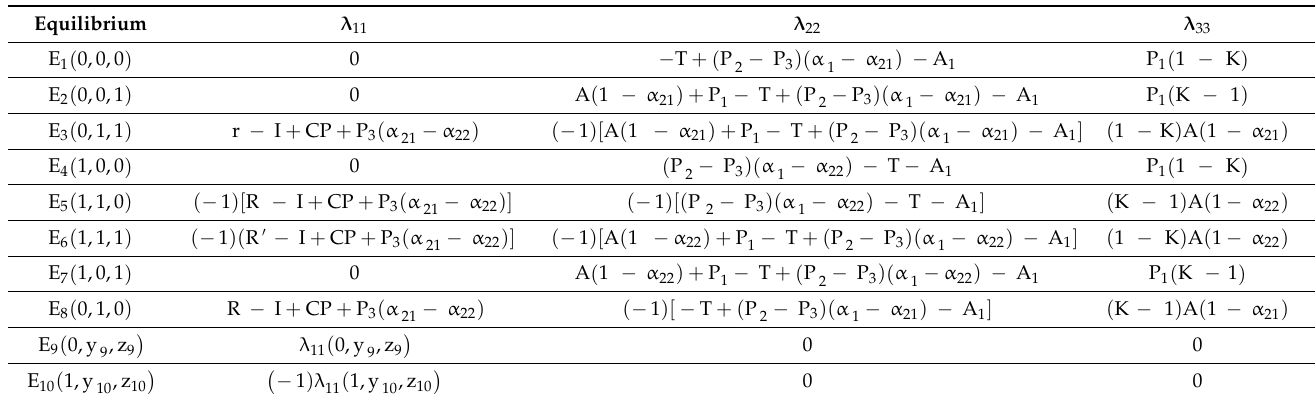
Table 5. The value at each local equilibrium point.